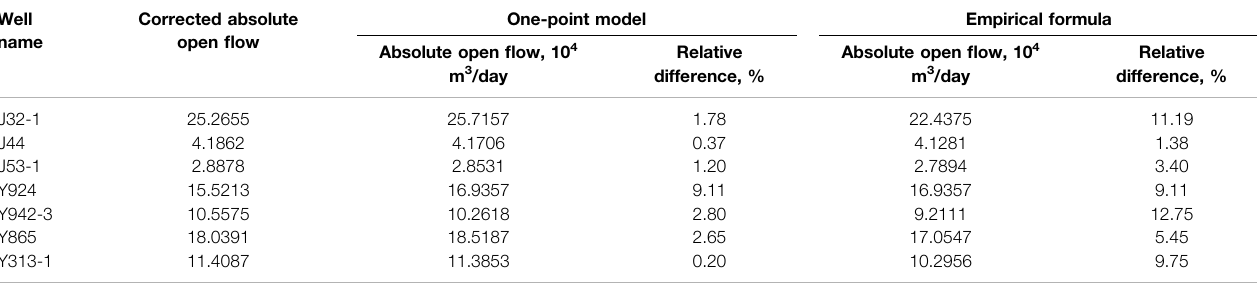
TABLE 5 | Comparison of two single-point deliverability formulas.